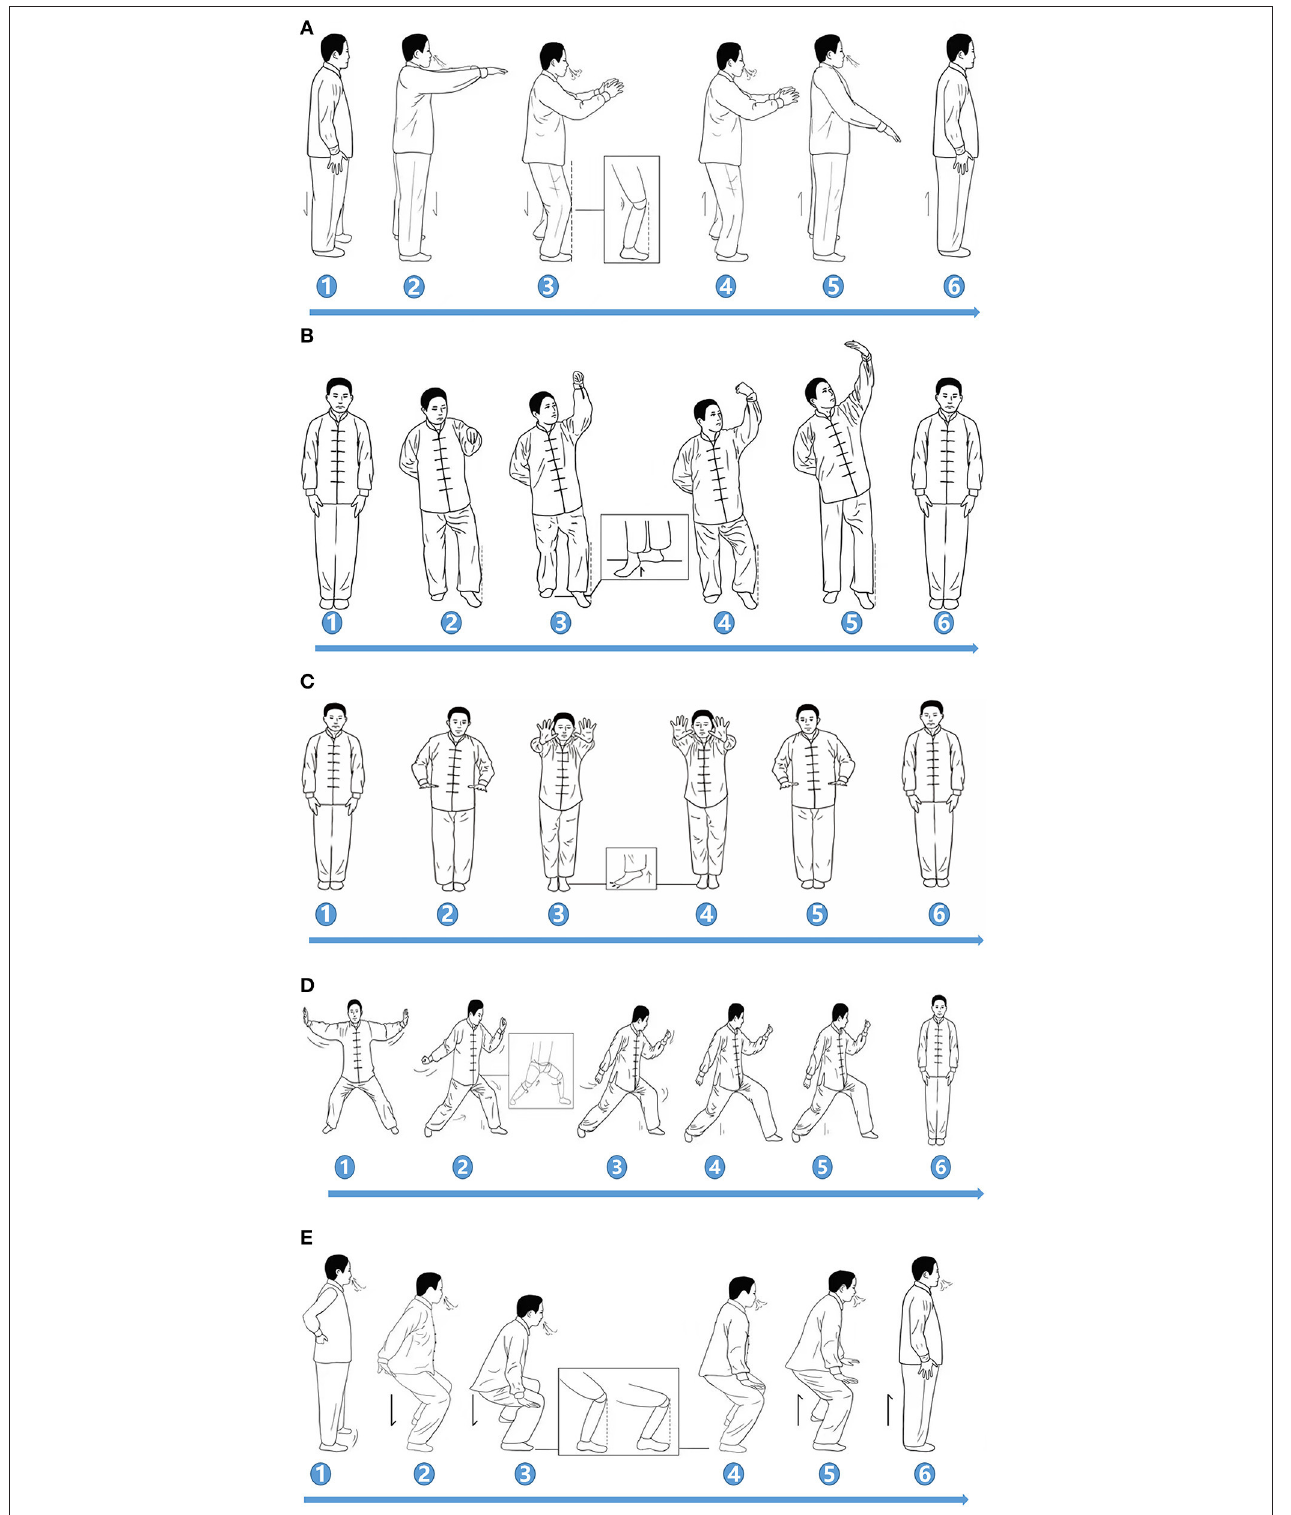
FIGURE 1 | Demonstration of YJJQE. The figure was a schematic diagram of five actions, mainly including knee flexion, timing of exhalation and inhalation, and the direction of eye observation. (A) Movement: Place both elbow joints flexed in front of the chest, Bilateral flexion (2,3), and extension (4,5) of the knee joint.